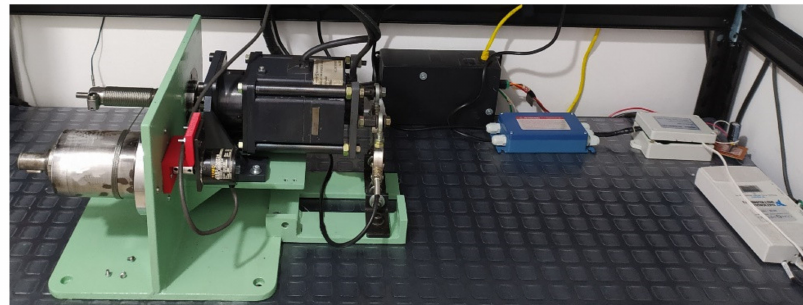
Figure 15. Experimental test bench for cable-driven